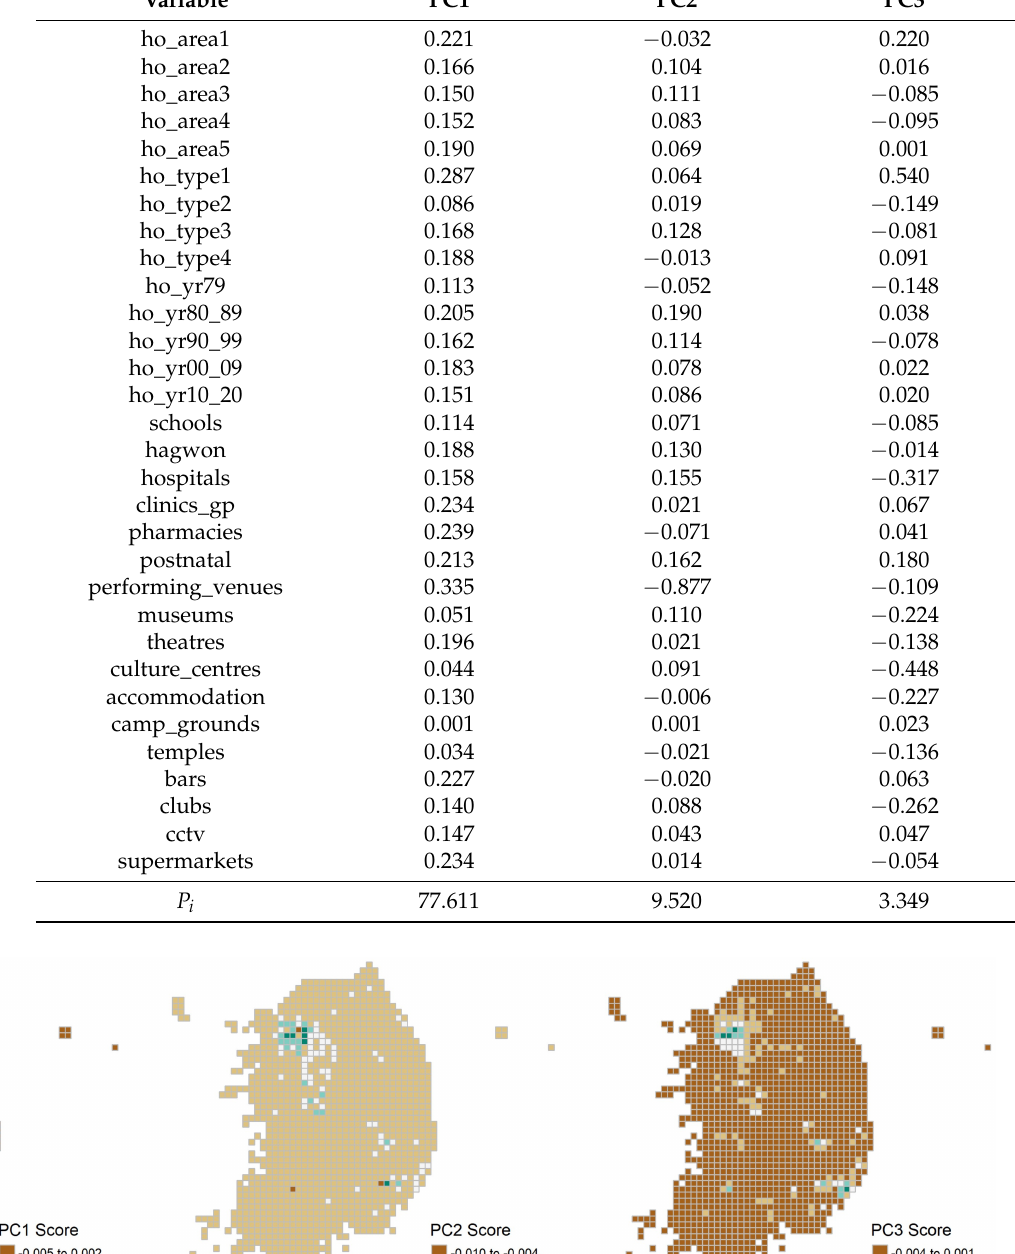
Table 2. Loadings of the first three PCs from the standard PCA.